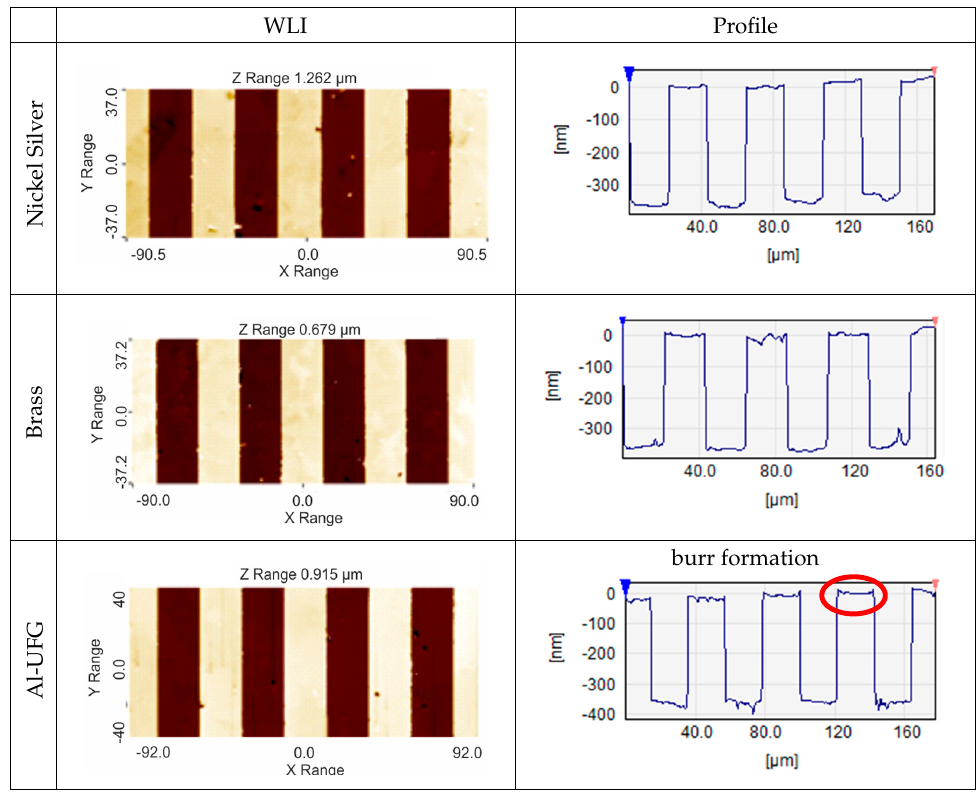
Table 3. Material impact on the structure geometry.